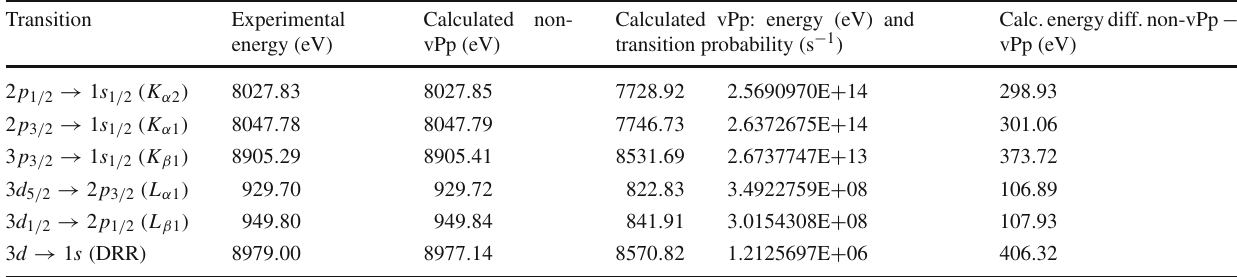
Table 2 Energy shift and transition probability of vPp-atomic transitions for copper